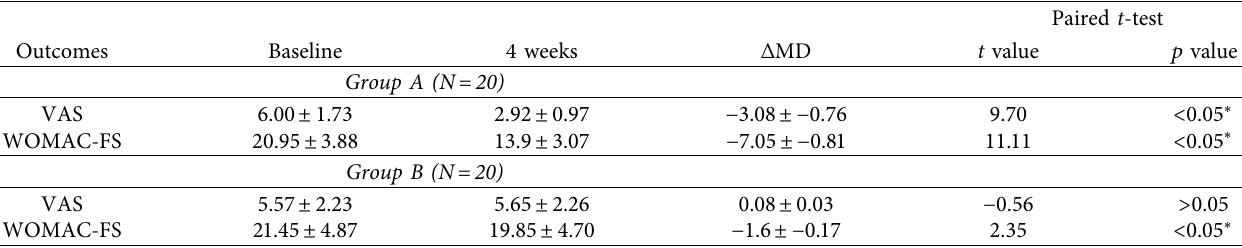
Table 2: Comparison of VAS and WOMAC functional status (mean ± SD) scores within Groups A and B using paired t -test.